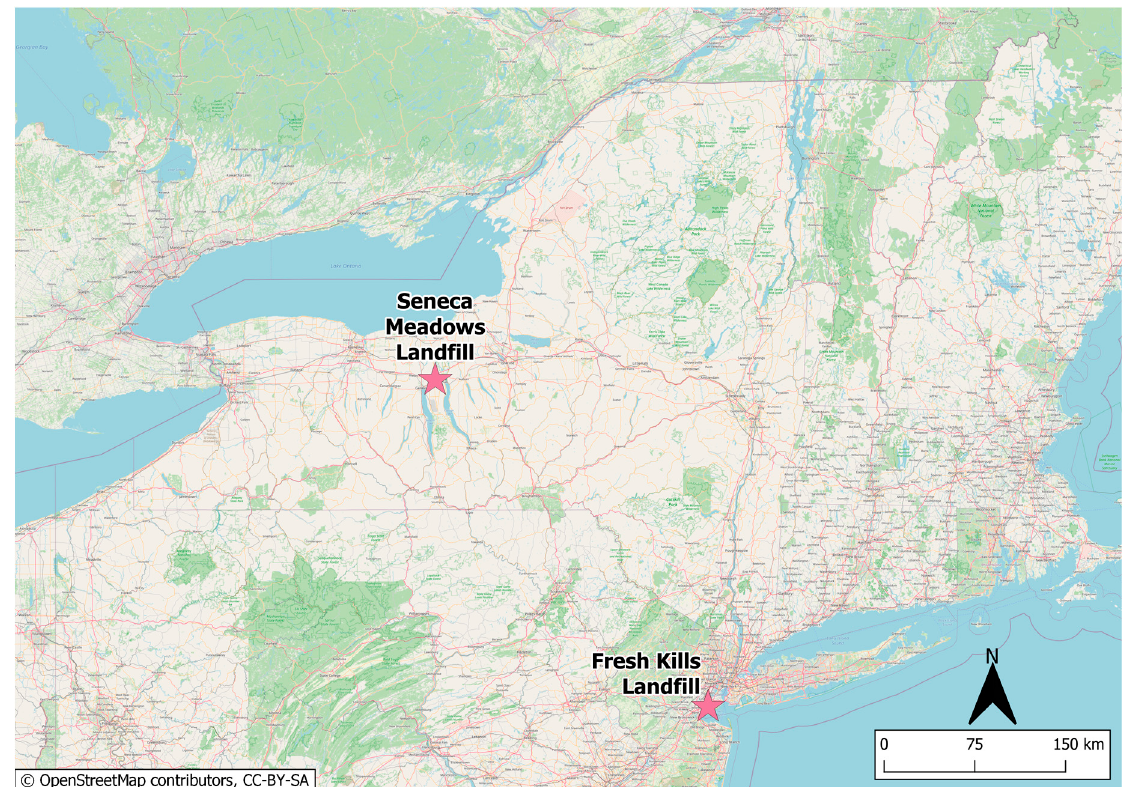
Figure 2. Site locations of Seneca Meadows Landfill and Fresh Kills Landfill using QGIS (https: //qgis.org/, accessed on 20 July